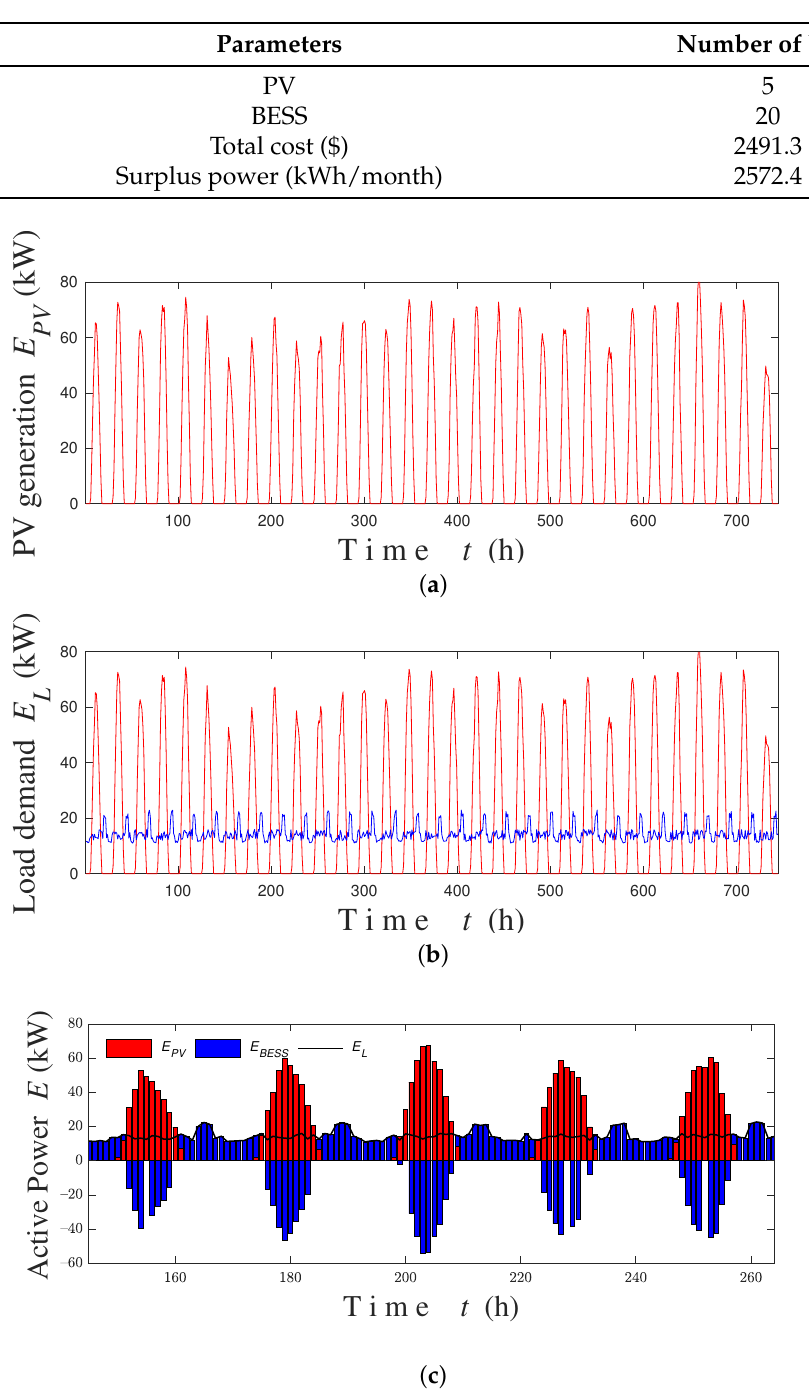
Figure 4. Simulation results of case 1. ( a ) The per hour PV generation. ( b ) The trends of PV power and load demand. ( c ) The simulation results for 5